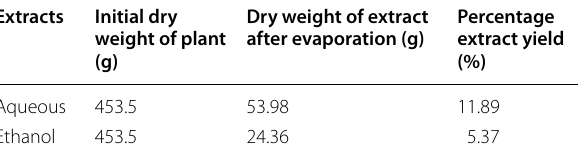
Table 3 Percentage extract yield Vernonia amygdalina leaf